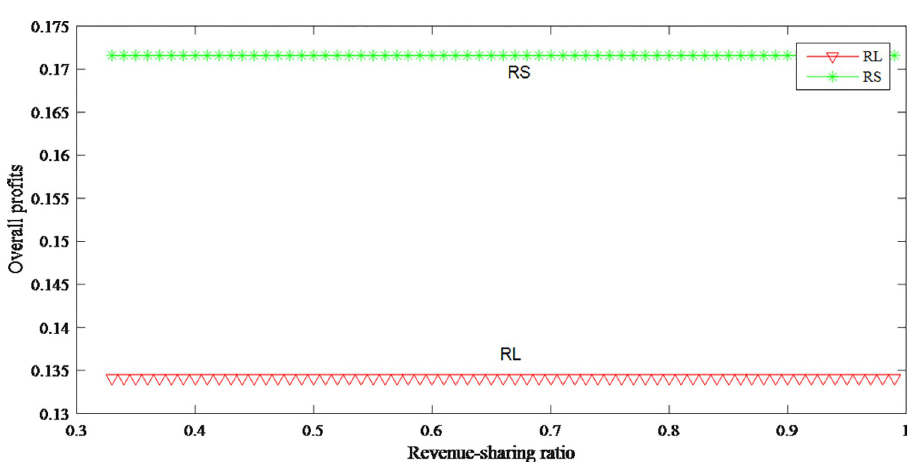
Fig 28. The impact of revenue-sharing contract on the overall profits.